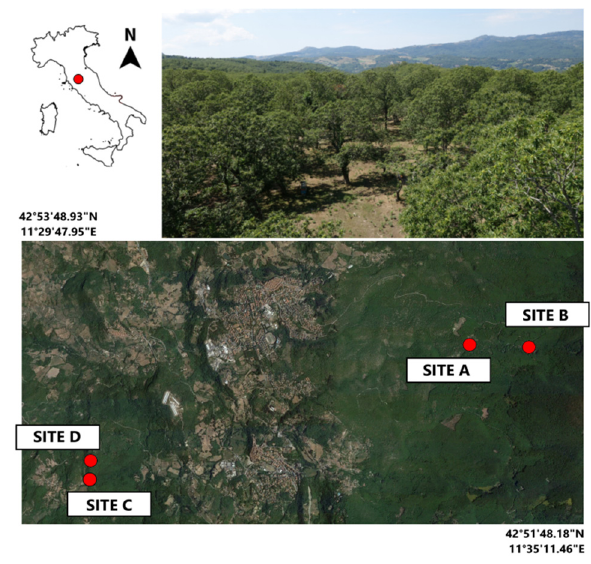
Figure 1. Experimental sites map.